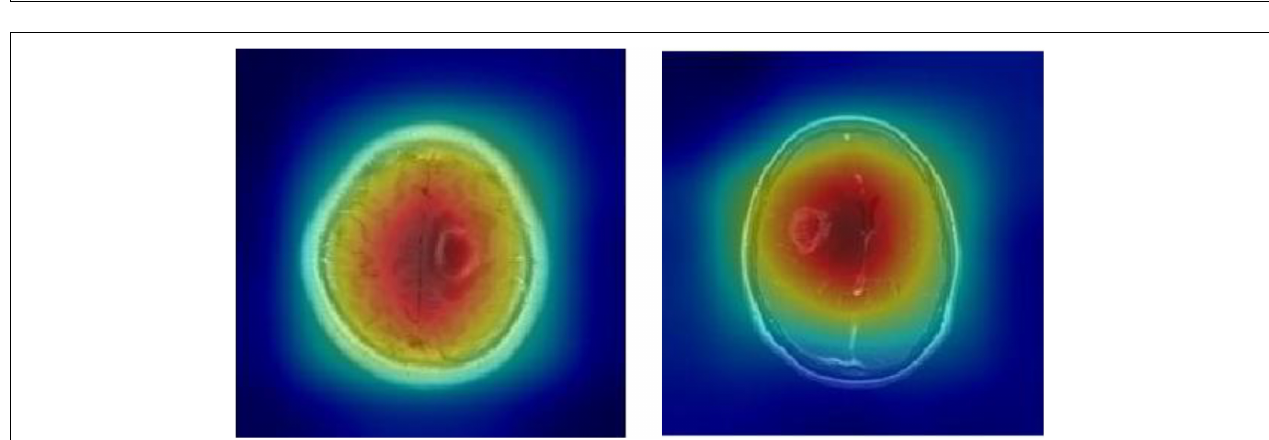
FIGURE 8 | Grad-CAMs of primary brain tumor